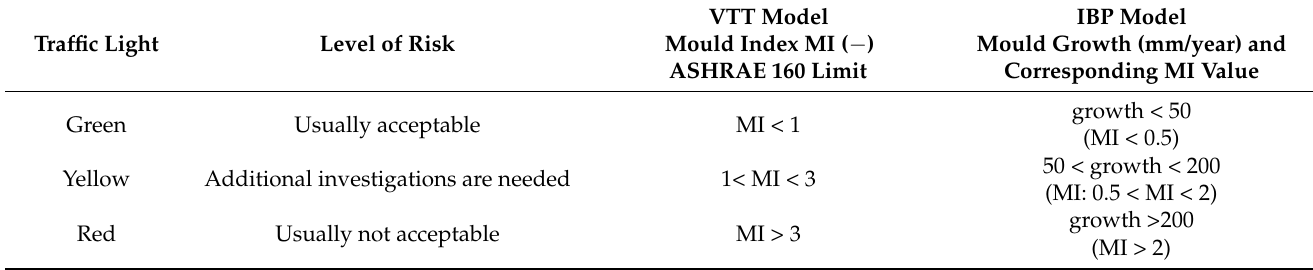
Table 1. Indication of the values of the traffic light scheme for the two different assessment